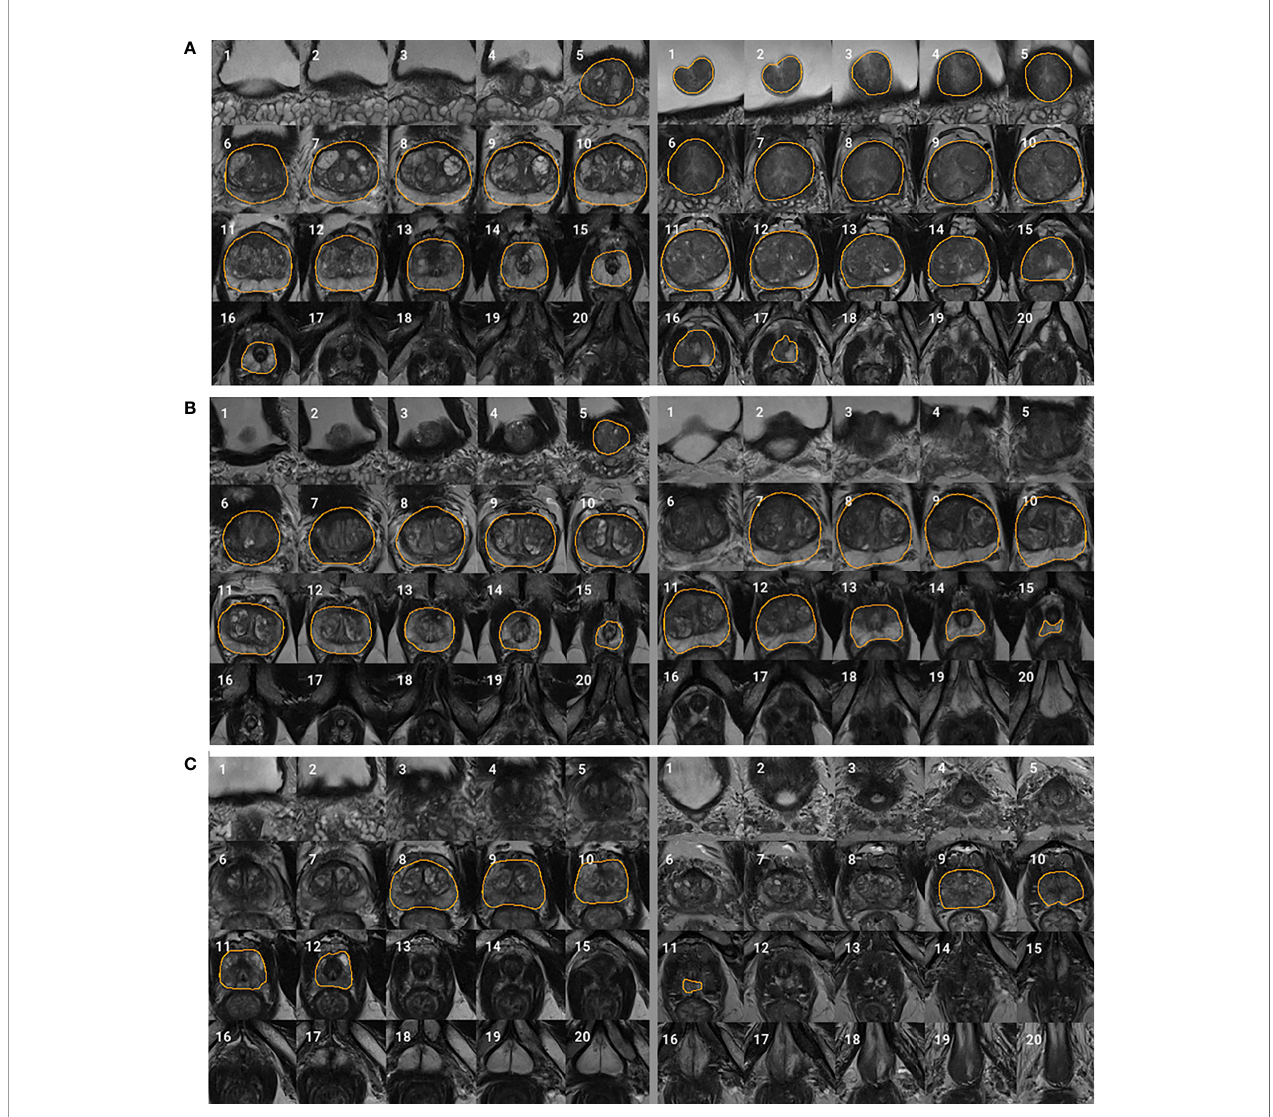
FIGURE 2 | Typical examples for each visual grade. Rows (A – C) represent two segmentation examples with visual grades 3 (excellent), 2 (acceptable), and 1 (unacceptable), respectively. Slices 1 – 20 represent MRI slices from superior to inferior. Regions encircled by organ boundary are the prostate whole gland.